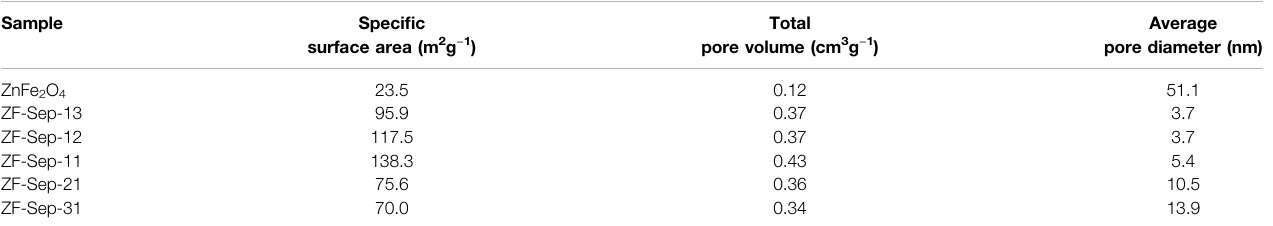
TABLE 1 | Textural parameters of ZnFe 2 O 4 , and the ZF-Sep composites with different contents of ZnFe 2 O 4 . Sample